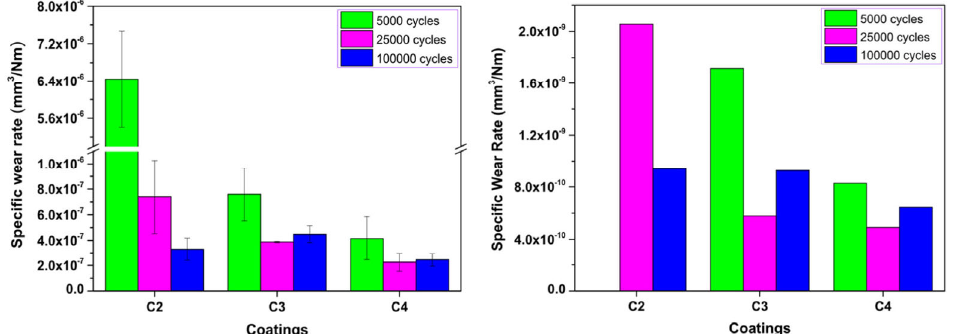
Fig. 32 Comparisons of the wear rate of different coatings (left) and the counter steel ball (right) in different numbers of sliding cycles. C2: MoSe 2 doped 18%C; C3: MoSe 2 doped 22%C; C4: MoSe 2 doped 27%C [383]. Reproduced with permission from Ref.